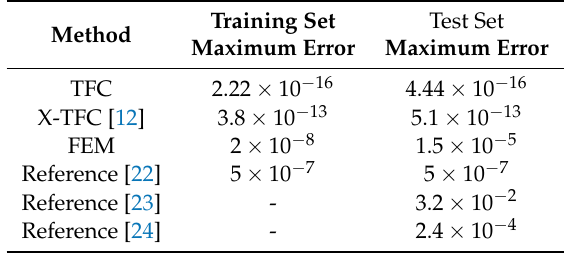
Table 4. Comparison of maximum training and test error of TFC with current state-of-the-art techniques for Problem #